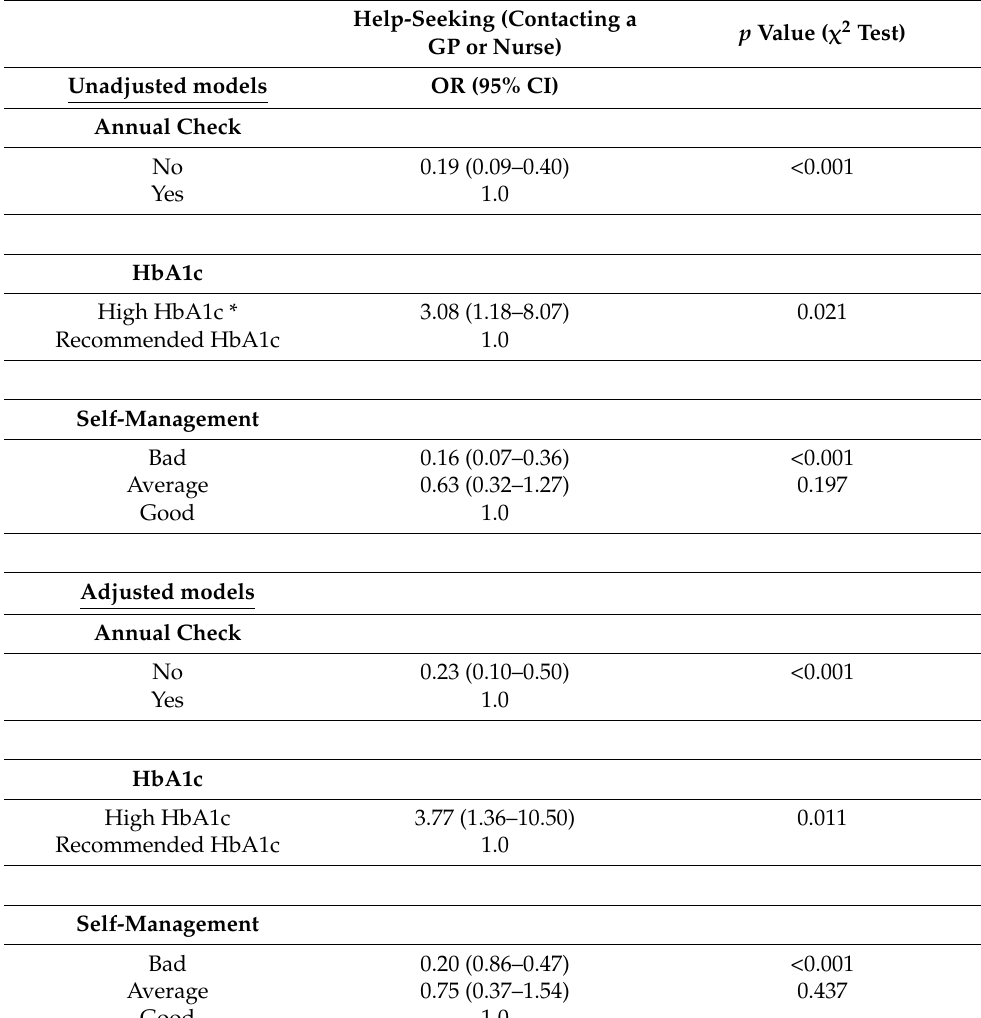
Table 3. Odds ratios and 95% confidence intervals for the association between diabetes management and help-seeking among the subgroup of participants with diabetes, adjusted for age and sex ( n =